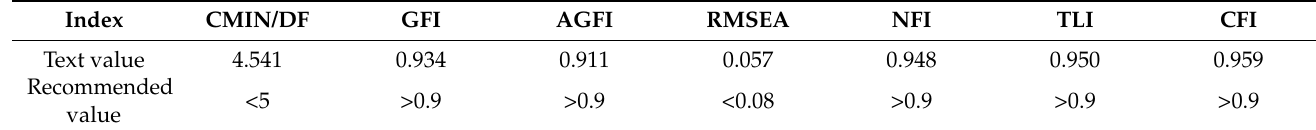
Table 6. Structural model fitting